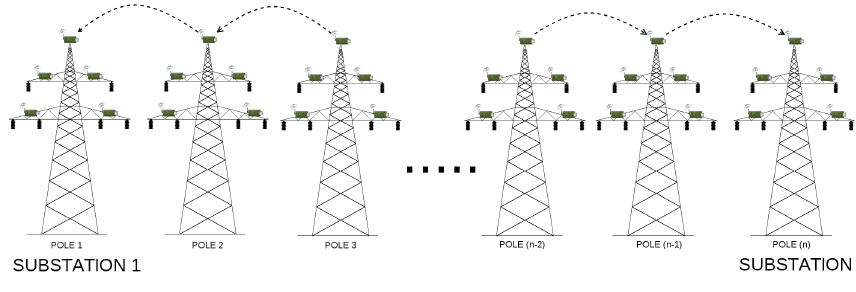
Figure 3. Default, hop-by-hop WSN architecture deployed on the example transmission grid.